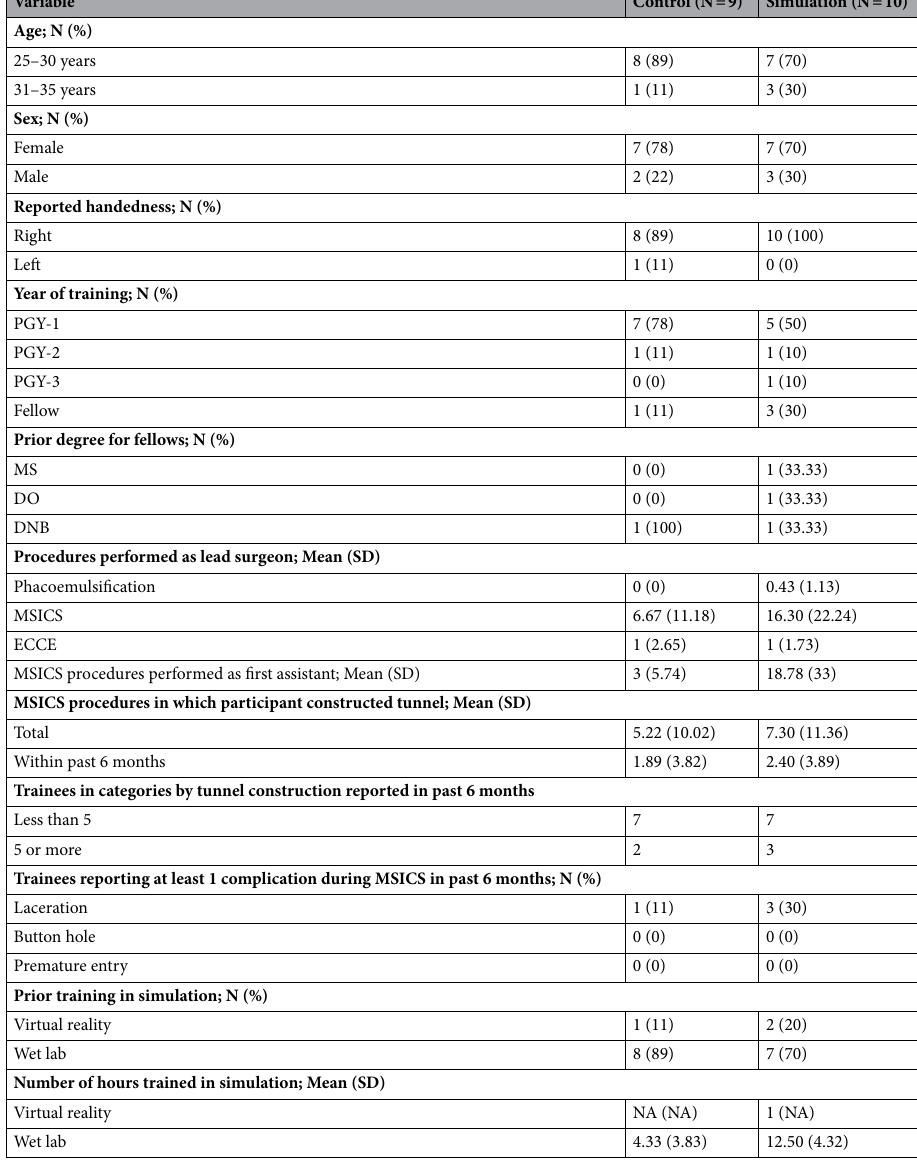
Table 1. Characteristics of trainees as assigned and analysed in this study. PGY post-graduate year, MS Master of Surgery, DO Diploma in Ophthalmology, DNB Diplomate of the National Board, MSICS manual small incision cataract surgery, ECCE extra-capsular cataract extraction, SD standard deviation, NA not